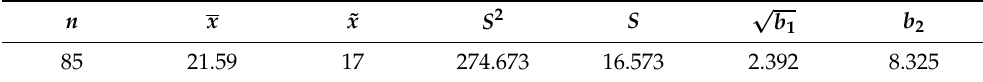
Table 1. Main descriptive statistics for nickel concentration